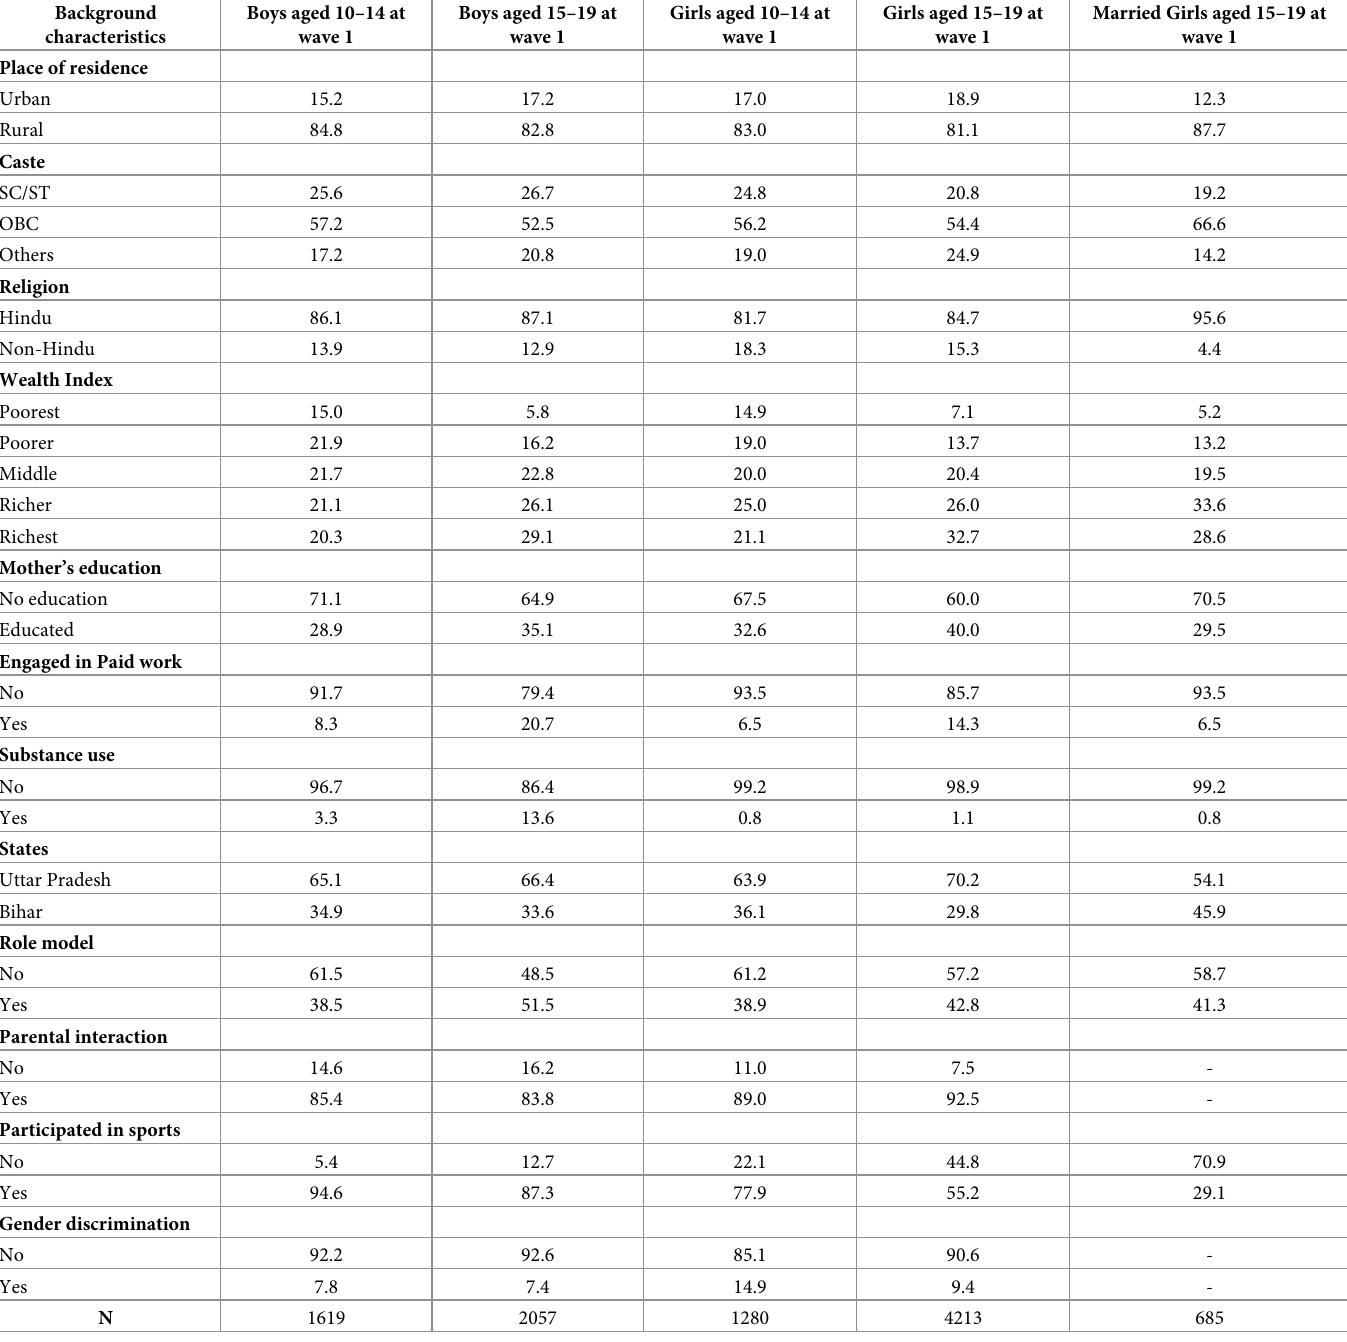
Table 1. Sample distribution of the study population, 2015–16. Background